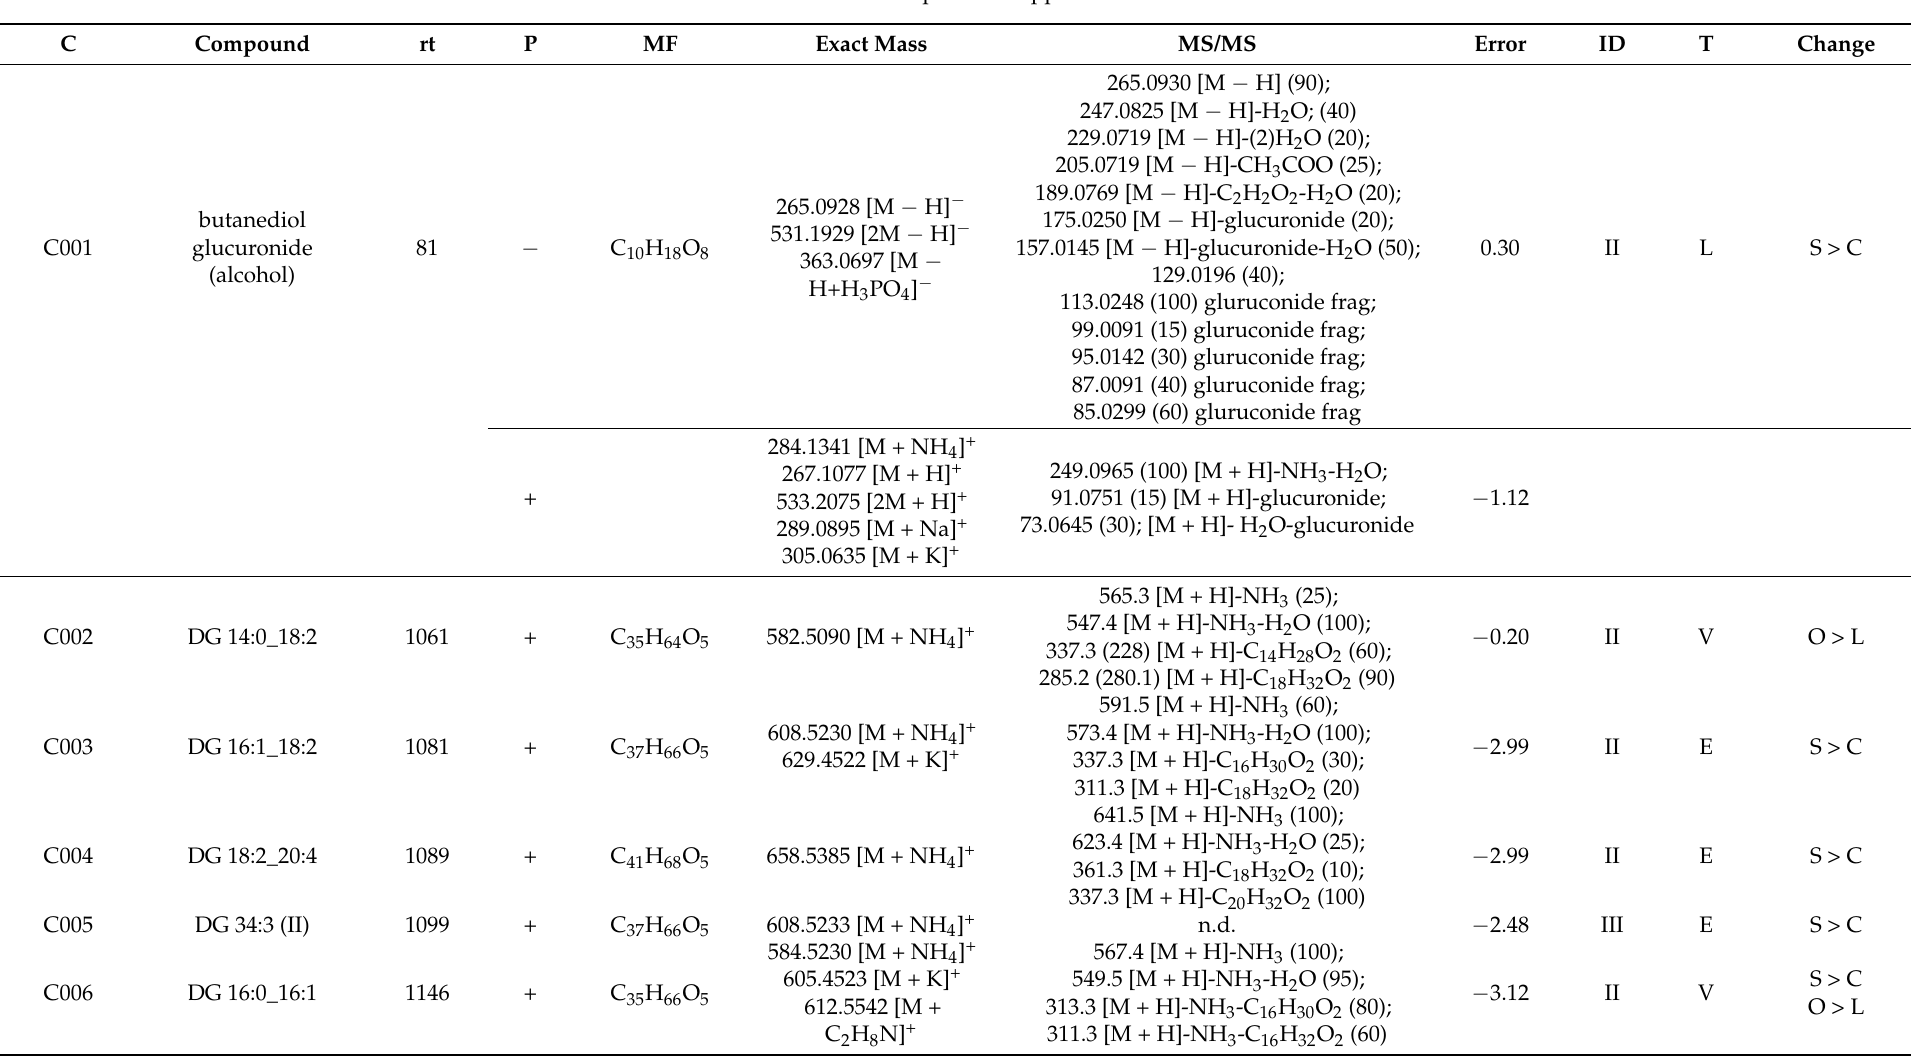
Table 1. Identification of markers in the metabolomics and lipidomics